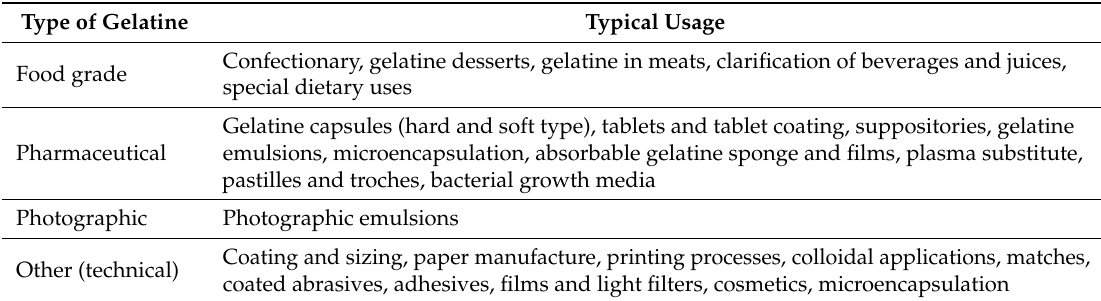
Table 1. Usage of gelatine depending on type